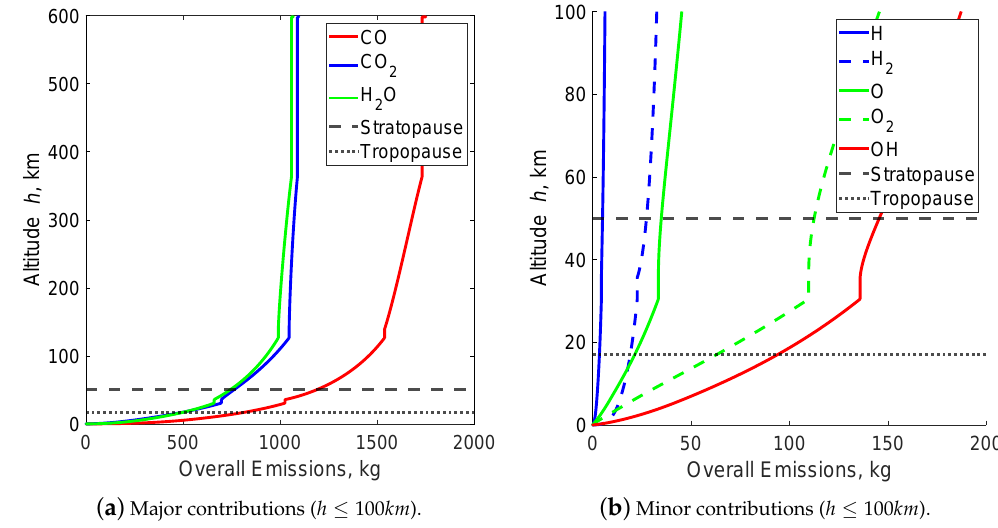
Figure 7. Contributions of the considered exhausted gases to the overall launcher emissions: REF case. As expected, the contributions of C 2 H 4 and CH 4 are negligible (omitted in (b)). The vertical branches in the plots (at about 30 km altitude) correspond to the coast arc for the first stage jettisoning, where thrust and propellant mass flow are